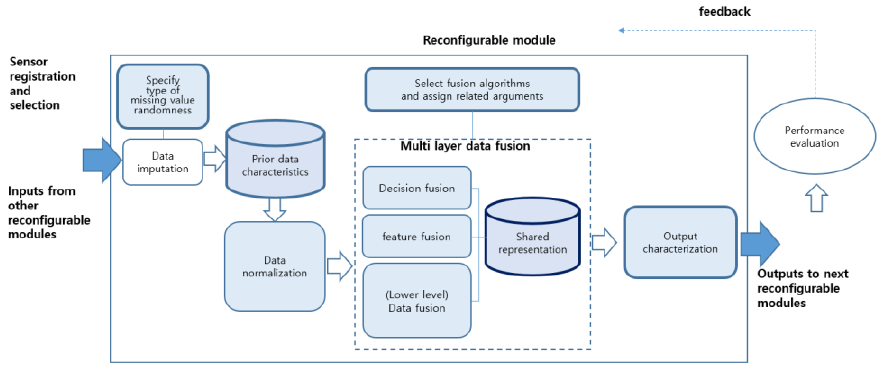
Figure 1. A reconfigurable module with layered architecture.